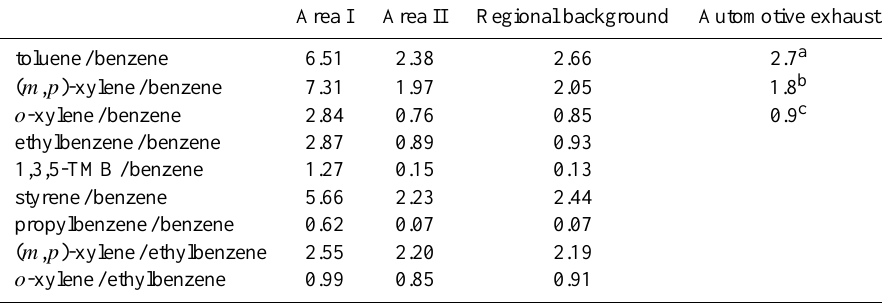
Table 1. The aromatic hydrocarbon ratios for the specific source